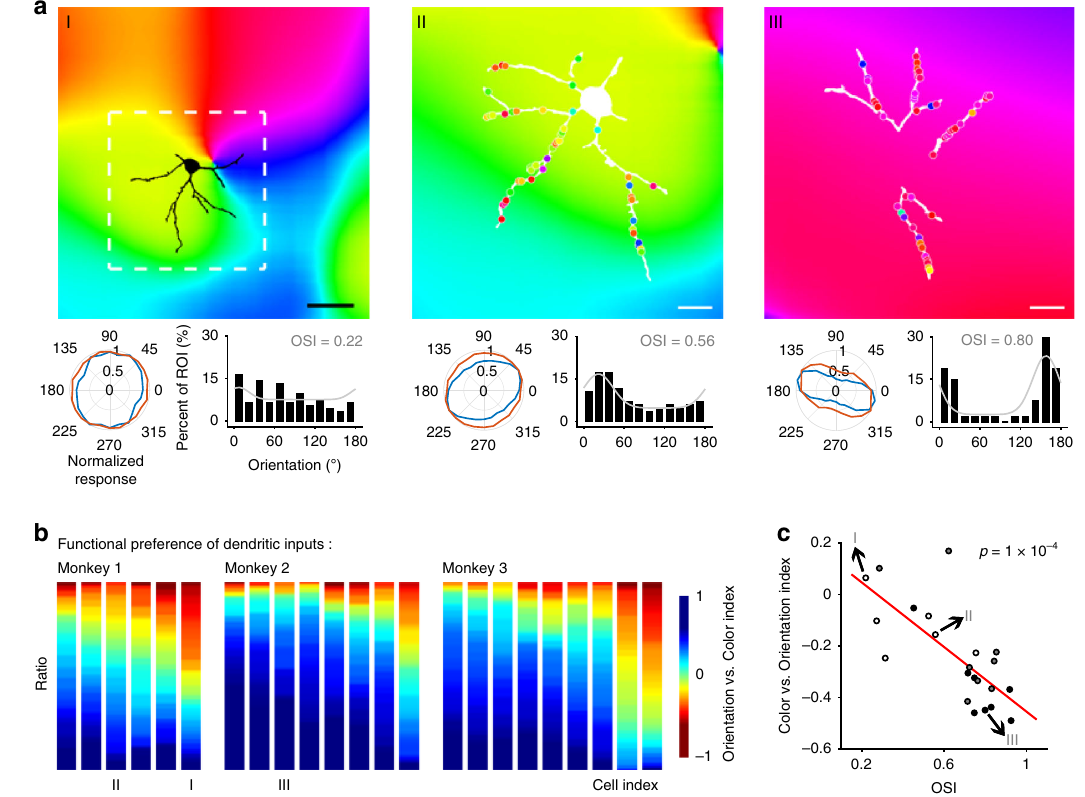
Fig. 3 Functional integration and trade-off between orientation/color inputs in individual V1 neurons ’ basal dendrites. a Left panel, top, neuron position on local orientation map (measured with global iGluSnFR fl uorescence, depth of 127 μ m on Day 71 post-injection). White dashed square, 166 µ m in width and height, corresponding to 100 pixels in raw two-photon images; scale bar, 50 µ m. Left panel, bottom left, normalized polar plots of orientation tuning of summed ROI responses (blue lines) and local cortical orientation selectivity (averaged response within a local area marked by the white dashed square; red lines); bottom right, frequency distribution of ROIs ’ preferred orientation fi tted with Gaussian functions (gray curves). Orientation selectivity index (OSI) of the fi tted curve represented input consistency. Right two panels, dendritic orientation map of another two sample neurons (recorded at depths of 206 and 286 μ m on Day 74 and Day 91, respectively) overlaid on local population orientation maps. Scale bar, 20 µ m. b Statistics of functional preference between orientation vs. color for all 23 measured neurons, sequenced by the average orientation vs. color index value. c Color vs. orientation index for each neuron vs. its